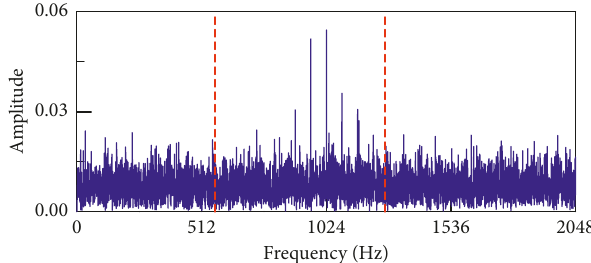
Figure 9: The boundaries obtained by the OSSR approach and the differences in the lengths of scale-space curves.